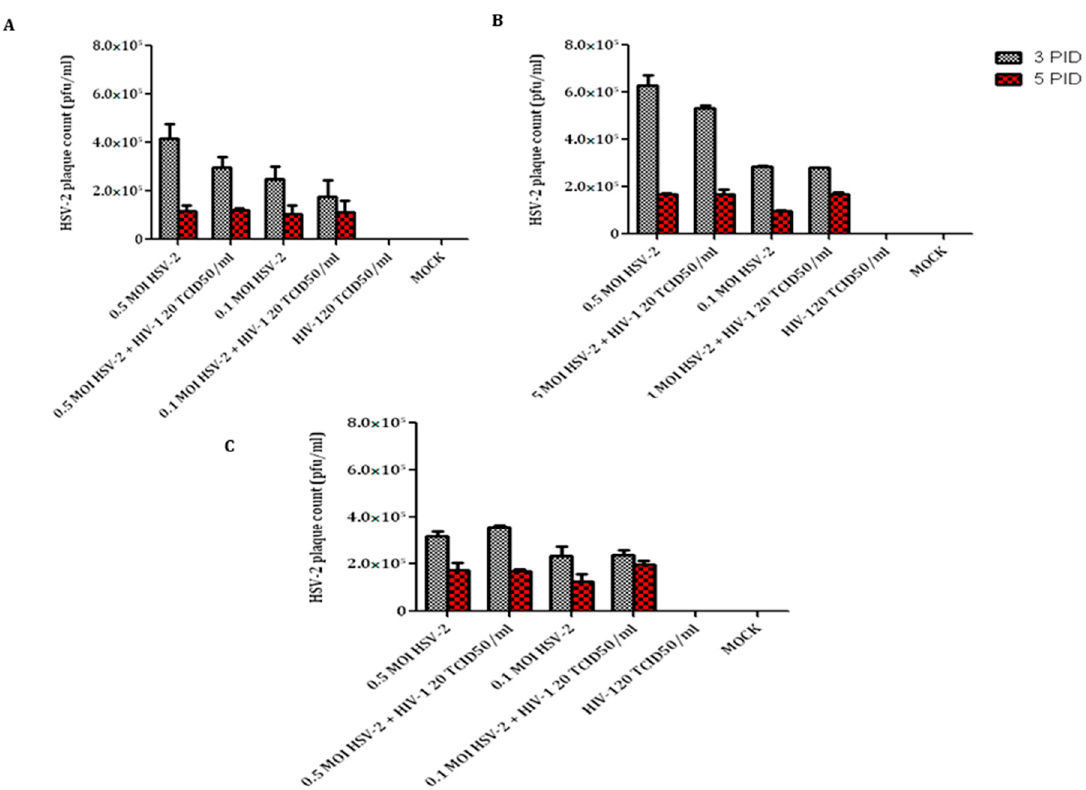
Figure 3. Infectious centers obtained by co-culturing infected T-cells with Vero cells: Plaque counts were obtained by exposing Vero monolayers to T-cells CEM CCR5+ ( A ), A3R5.7 ( B ), and primary CD4+ T-cells ( C ) infected with HSV-2 and/or HIV-1. Results for A3R5.7 and CEM CCR5+ represent data from three independent assays for T-cell lines and two independent donors for primary CD4+ T-cells.